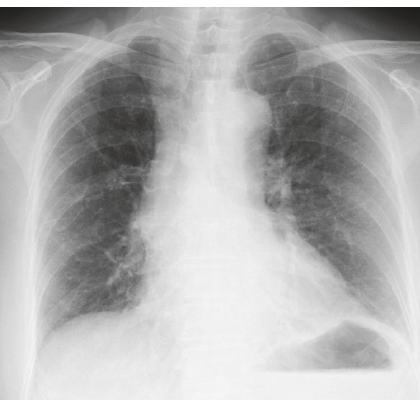
Figure 1: Chest X-ray one and a half months after the initiation of everolimus treatment, showing no infiltrative shadows in both lung